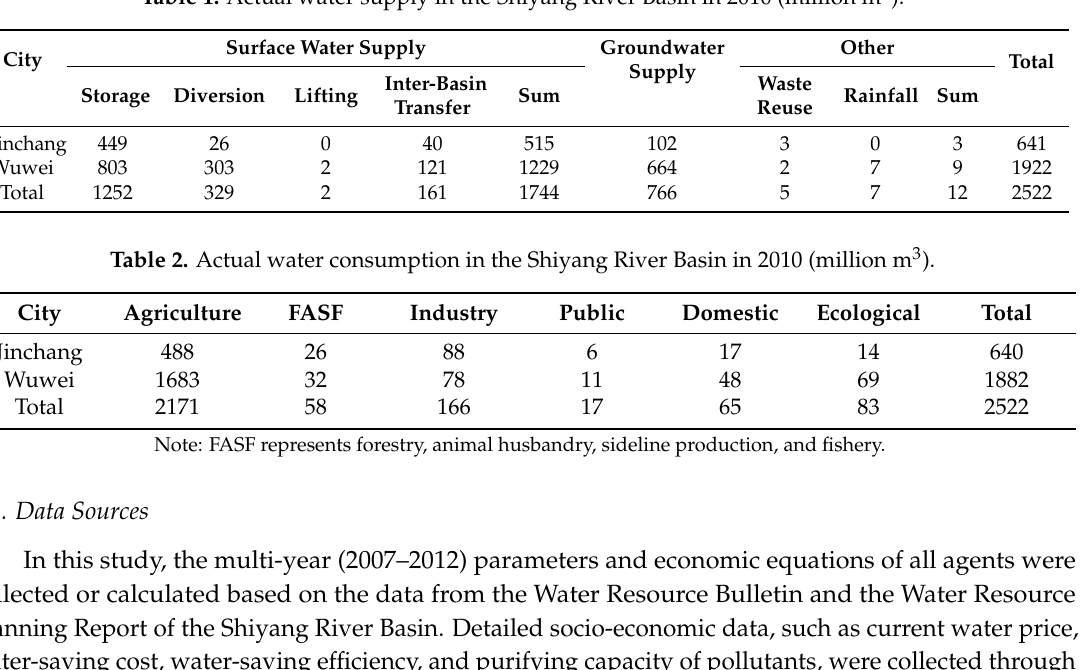
Figure 1. The study area. Table 1. Actual water supply in the Shiyang River Basin in 2010 (million m 3 ).